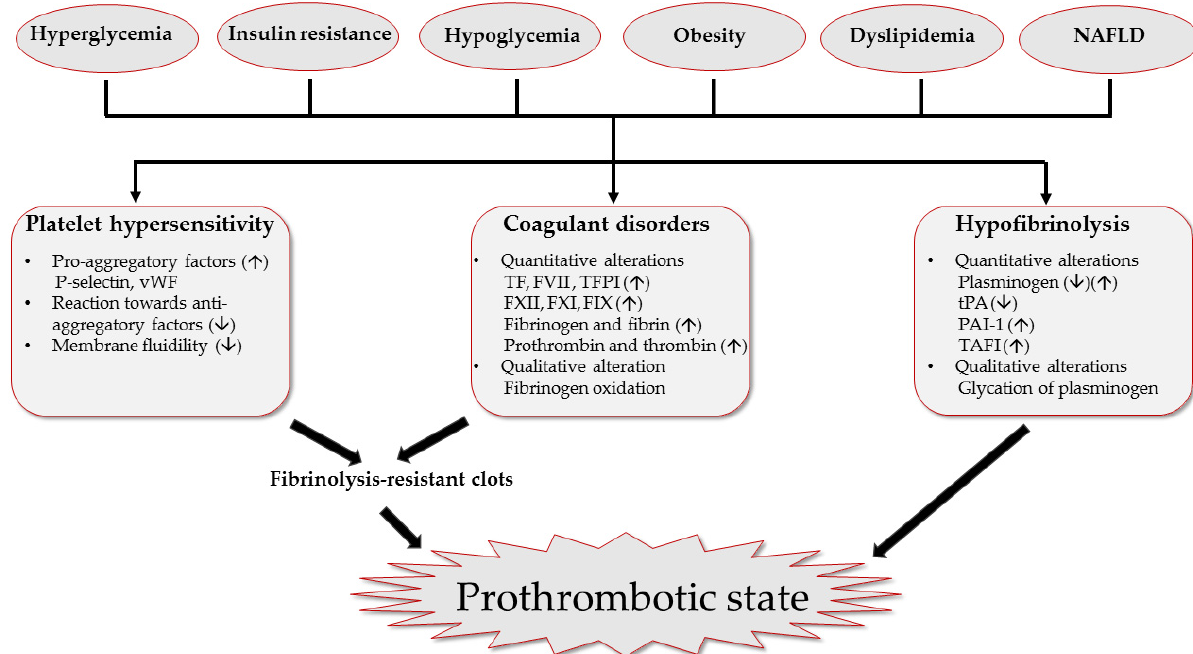
Figure 1. Modifications of coagulation and fibrinolysis system in DM. Diabetes disturbs the physiological balance between coagulation and fibrinolysis, leading to a prothrombotic state hallmarked with platelet hypersensitivity, coagulation factor disorders and hypofibrinolysis. Hyperglycemia and insulin resistance enhance number and aggregation of platelets through increasing von Willebrand factor (vWF) level and inhibiting anti-aggregatory efficiency of nitric oxide and prostaglandin I 2 . Hyperglycemia and insulin resistance upregulate level of pro-coagulation mediators like tissue factor (TF), coagulation factors (FVII, FXII, FXI and FIX) and thrombin. Diabetes also harasses fibrinolysis by decreasing tissue plasminogen activator (tPA) as well as increasing plasminogen activator inhibitor-1 (PAI-1) and thrombin activator fibrinolysis inhibitor (TAFI). Next to hyperglycemia and insulin resistance, co-existing metabolic disorders like hypoglycemia, obesity, dyslipidemia, and non-alcoholic fatty liver disease (NAFLD) also contribute to the pro-thrombotic state of patients with DM.